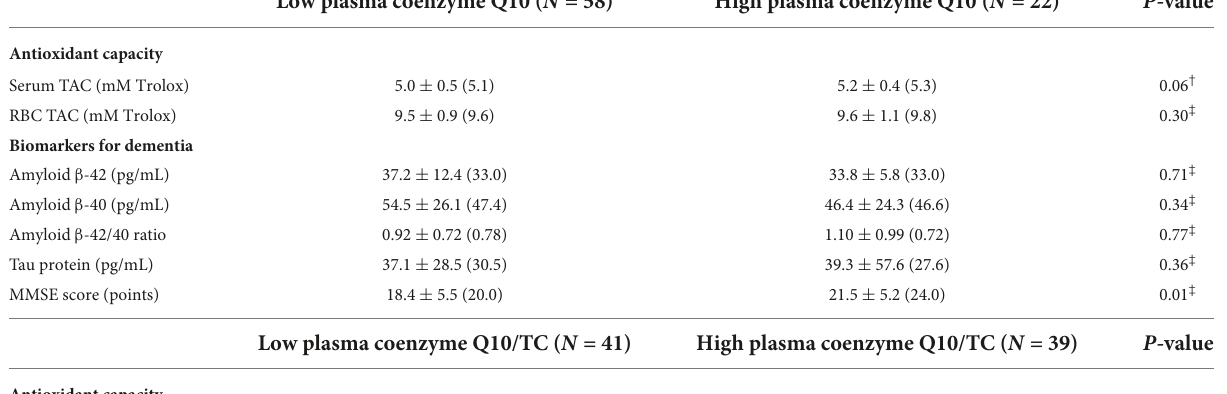
TABLE 2 Antioxidant capacity, biomarkers for dementia, and MMSE score of patients after stratified by coenzyme Q10 status. Low plasma coenzyme Q10 ( N = 58) High plasma coenzyme Q10 ( N = 22)